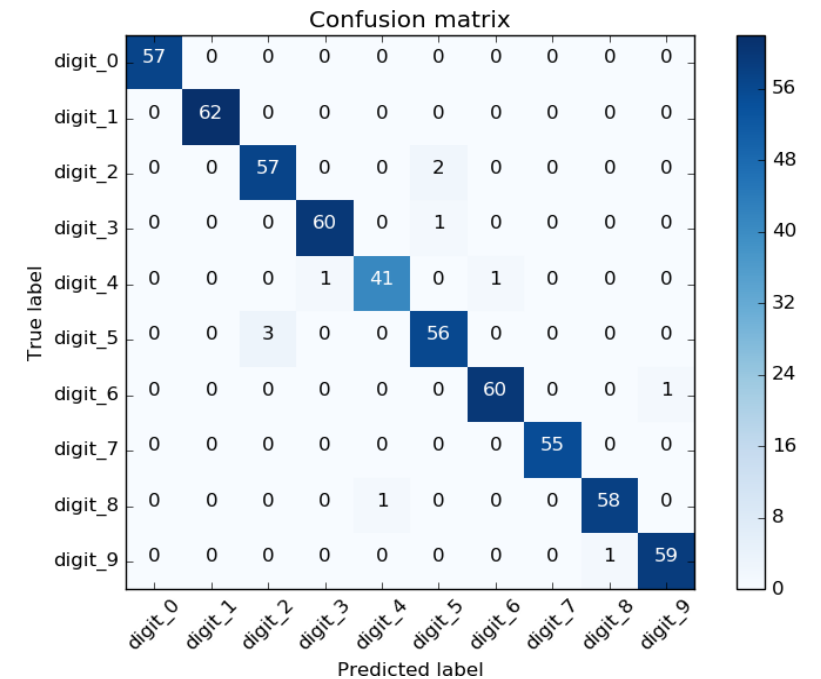
Figure 13. Confusion matrix on Kaggle Devanagari numeral dataset using fine-tune DHCD model with Adam